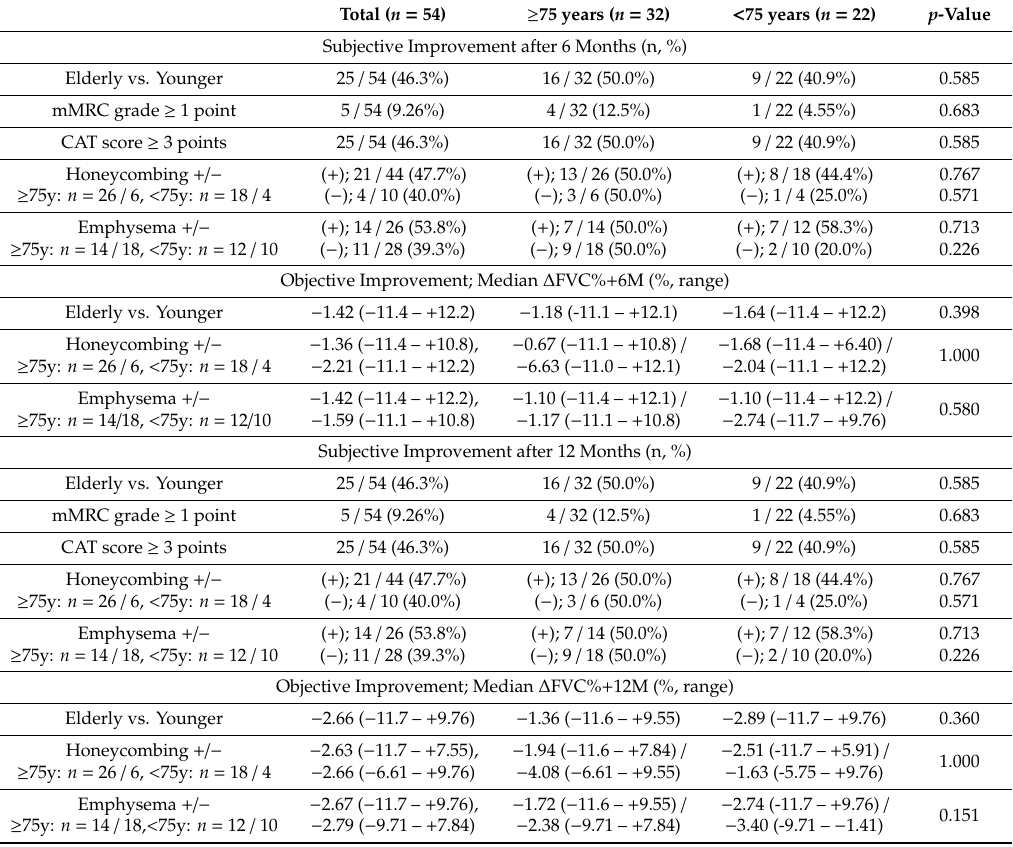
Table 2. Therapeutic E ff ects of